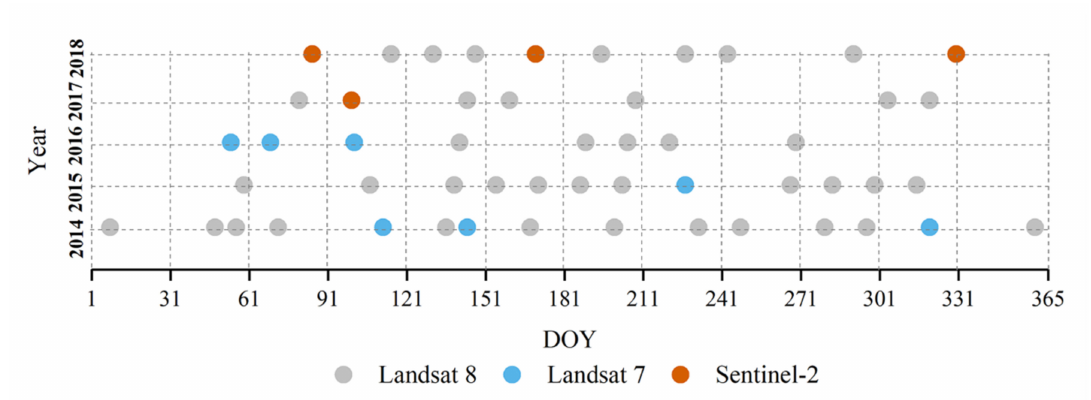
Figure 2. Available Landsat and Sentinel-2 time series that covered the study area from 2014 to